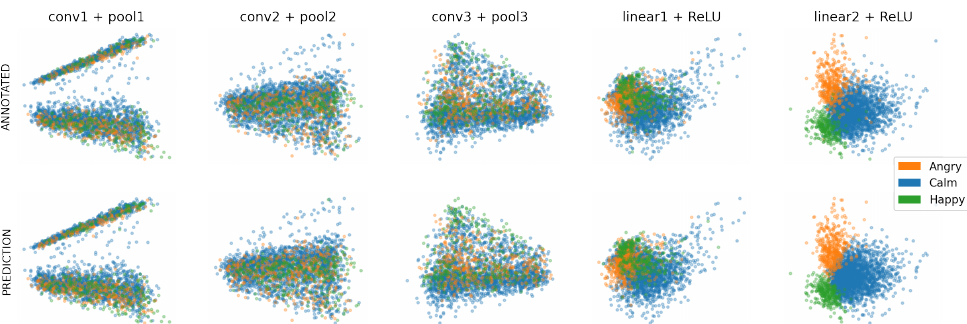
Figure 4. Two-dimensional representation obtained for each sample over different layers of the network using the PCA technique. The colour of each point represents the category to which it belongs, showing in the first row the annotated categories (ground truth) and in the second row the predicted